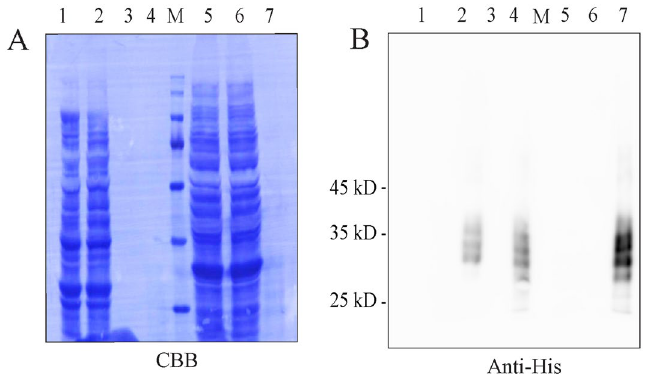
Figure 3. Purified CES3:His binds with E . coli . ( A , B ) Binding of CES3:His with E . coli and L. sakei cells. E . coli strain JM109 and L. sakei was grown in LB and MRS media, respectively overnight. The cells were collected by centrifugation and washed several times with PBS buffer. Purified CES3:His protein was incubated with E . coli and L. sakei cells. Cells were pelleted again by centrifugation and washed five times. The pellet fraction containing E . coli and L. sakei together with any bound proteins was boiled in SDS sample buffer, and proteins were separated by SDS-PAGE and stained with CBB ( A ) or analysed by western blotting using anti-His antibody ( B ). E . coli and L. sakei cells without protein incubation were used as a negative control. Lane 1, only E. coli without CES3:His treatment; lane 2, E. coli treated with CES3:His; lane 3, Flowthrough after binding with E. coli ; lane 4, only CES3:His protein as control; M, Protein Marker; lane 5, only L. sakei without CES3:His treatment; lane 6, L. sakei treated with CES3:His; lane 7, Flowthrough after binding with L. sakei.